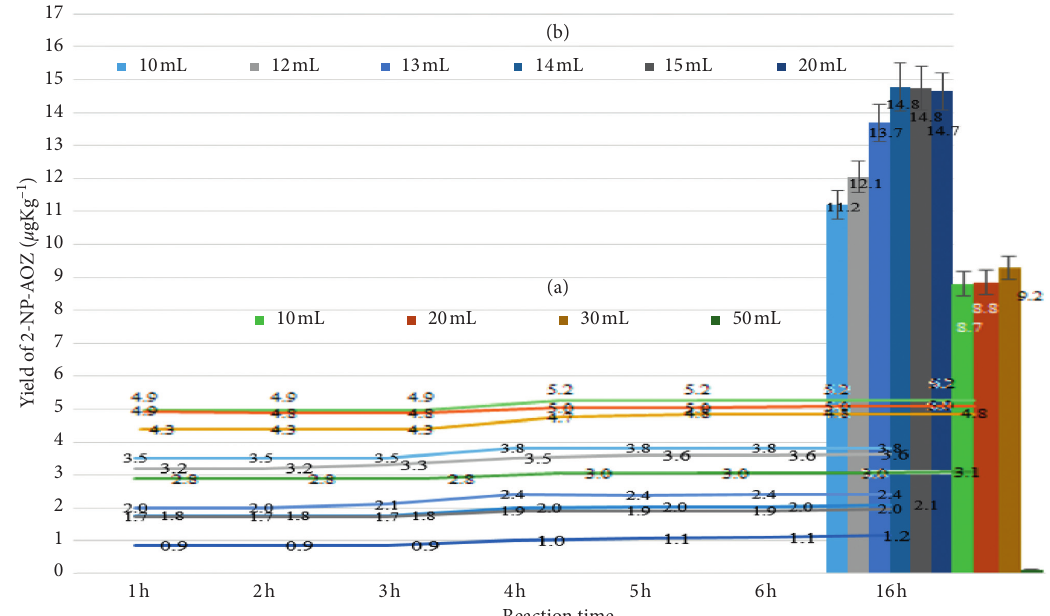
Figure 2: Change in pH over time and amount of 2-NP-AOZ detected in the incurred sample. (a) Concentration of detected 2-NP-AOZ in samples treated with 10, 20, 30, and 50mL of 0.125M HCl at 37 ° C. The results of the experiments with 50mL were discarded because of errors. (b) Concentration of detected 2-NP-AOZ using 10, 12, 13, 14, 15, and 20 mL of 0.5M HCl at 45 ° C. ∗ Line graph: pH value over time (unit: pH). ∗∗ Bar graph: final detected concentration of 2-NP-AOZ in the incurred sample under each test condition (unit: μ g kg − 1 ).